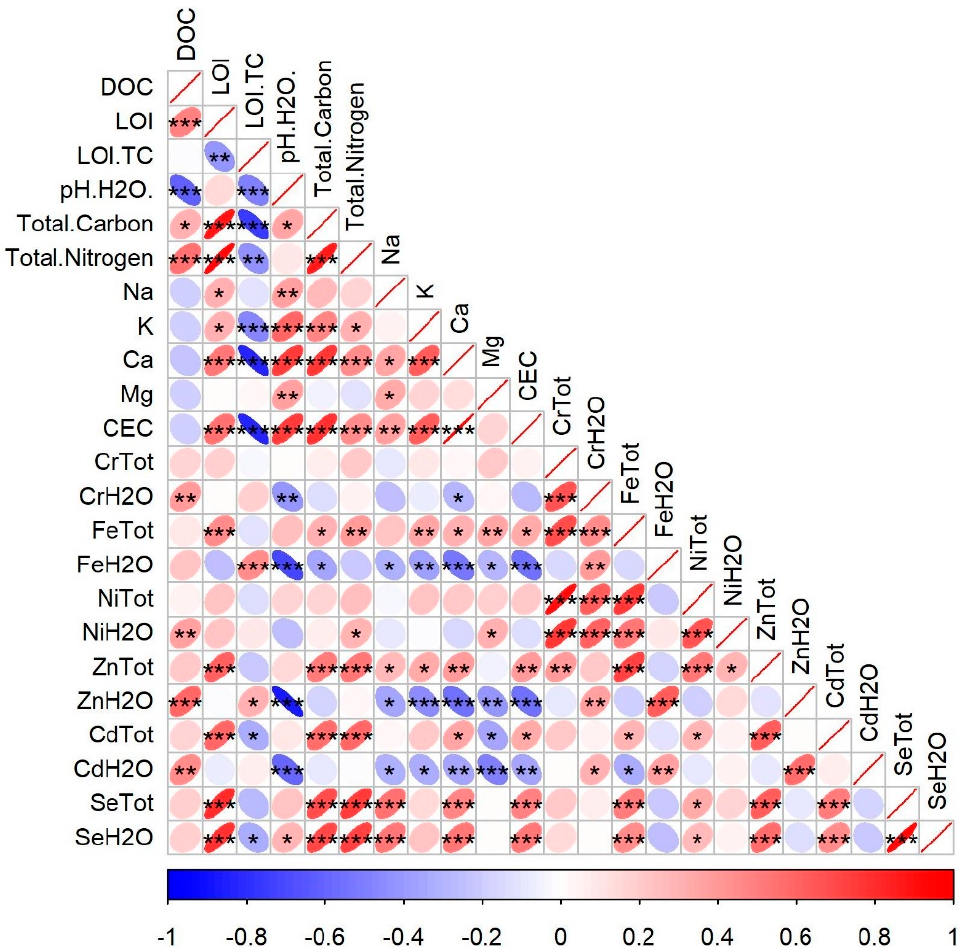
Figure 1. The illustration shows the negative ( − , blue) and positive (+, red) correlations between soil properties and total soil and total water-extractable concentrations of several elements. Significance of correlation is denoted with * ( α = 0.05), ** ( α = 0.01), and *** ( α = 0.001). To assess the grouping of soils according to the analyzed properties, PC analysis was carried out. The first three principal components explained 73.6% of the variation in the data set, with 61.1% in the first two components (36.9% by PC1 and 24.2% by PC2, Figure 2). An inspection of the biplot (for communalities see Supplementary Table S1) showed that PC1 was mainly correlated with LOI/TC in the positive direction and TC, CEC, Ca, Mg, Na, and K in the negative direction. PC2 was in a positive correlation with DOC and the water extracts of heavy metals, and in a negative correlation with pH and Mg (Figure